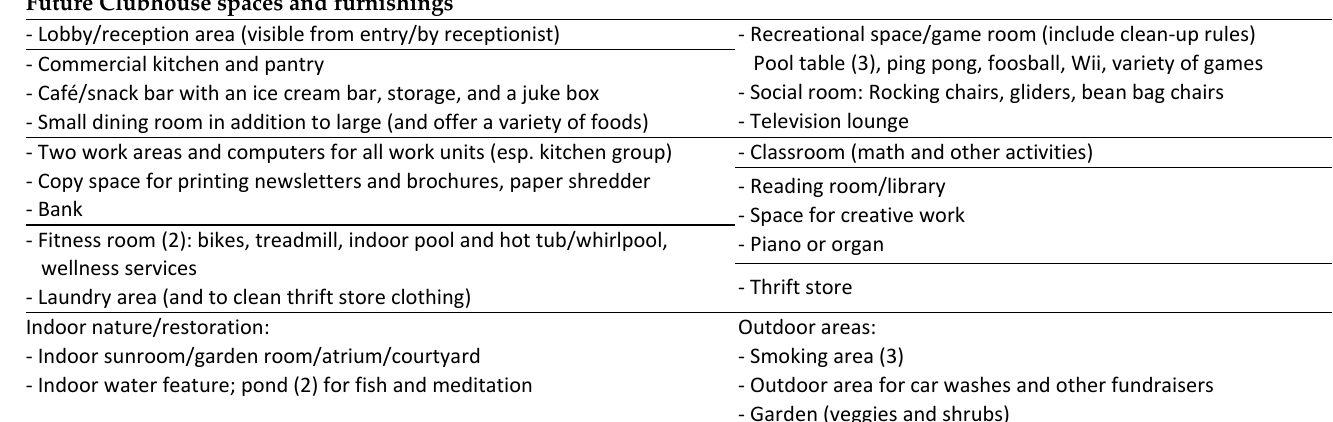
Figure 3. Future Clubhouse space and furnishing preferences. Numbers indicate the quantity of Member responses including that item. No number indicates that there was one Member response.